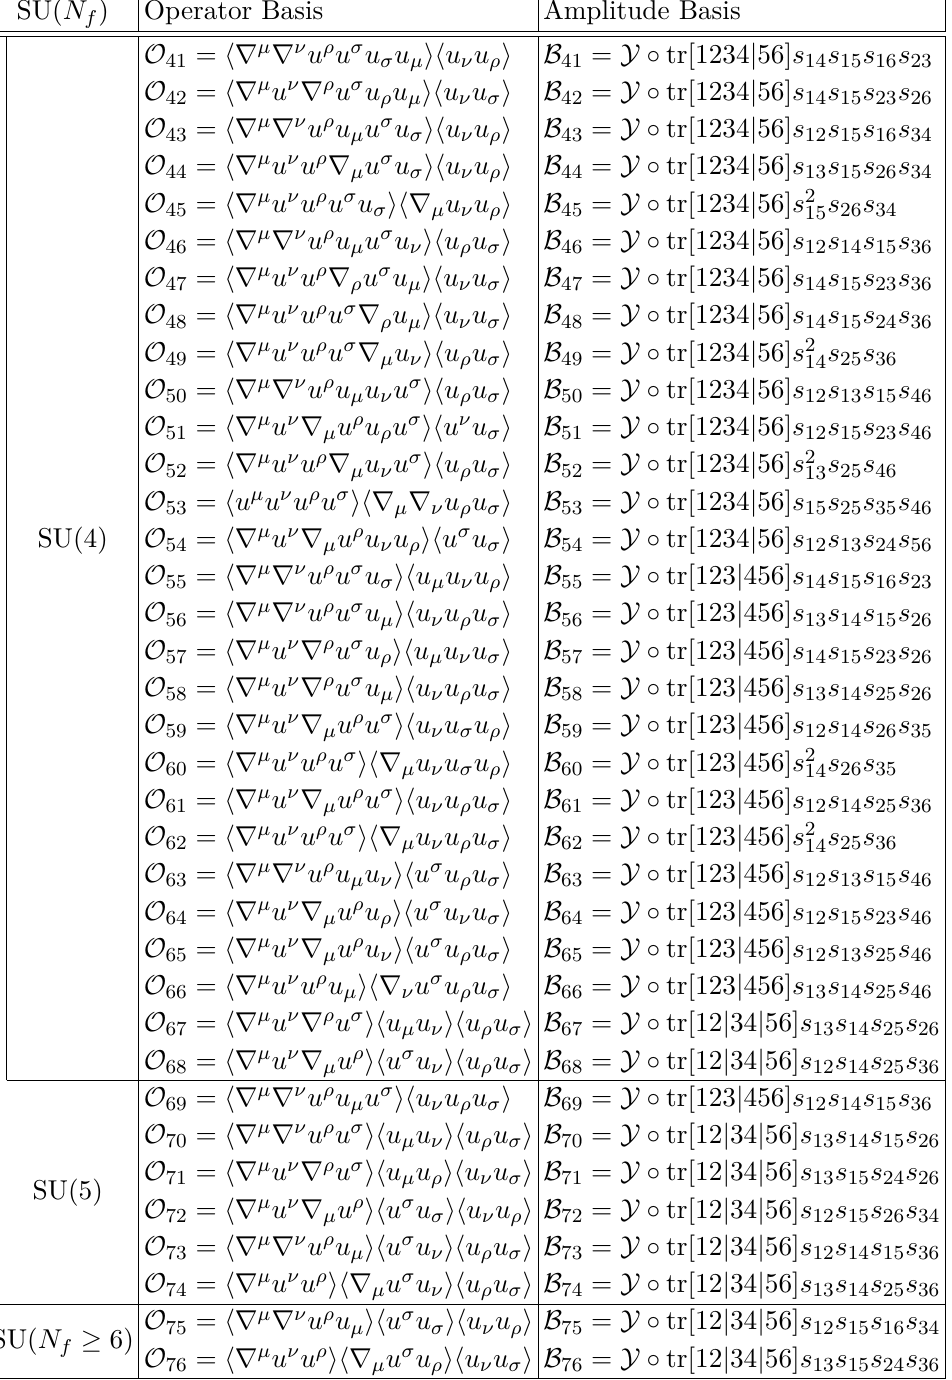
6) flavour groups are 8 , 40 , 68 , 74 f ≥